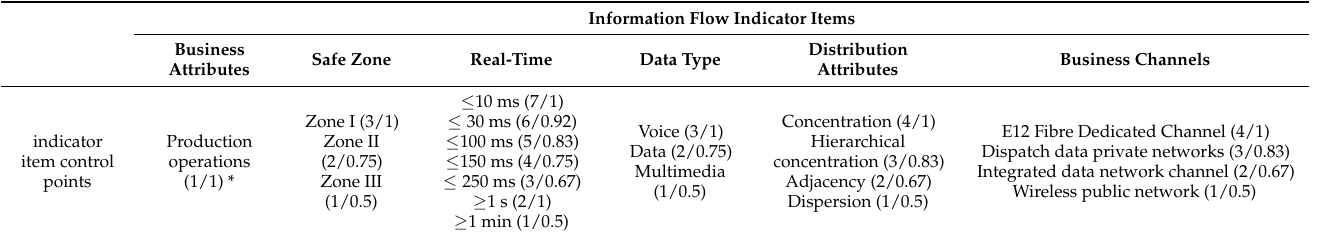
Table 2. Information flow indicator items, indicator item control points, and their value distribution.